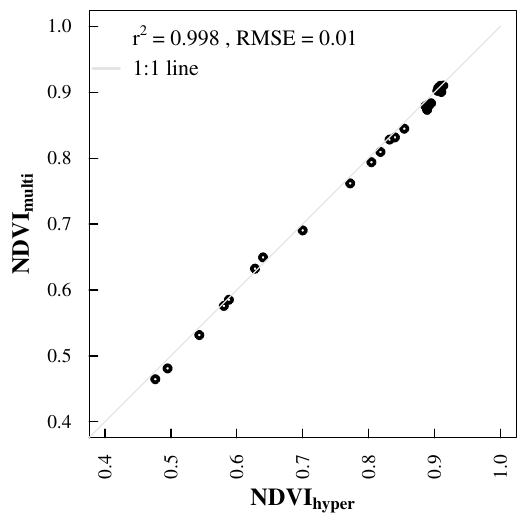
Figure 6. Scatter-plot of NDVI derived from the hyperspectral sensor system ( NDVI hyper ) vs. NDVI from the multispectral sensor system ( NDVI multi ).